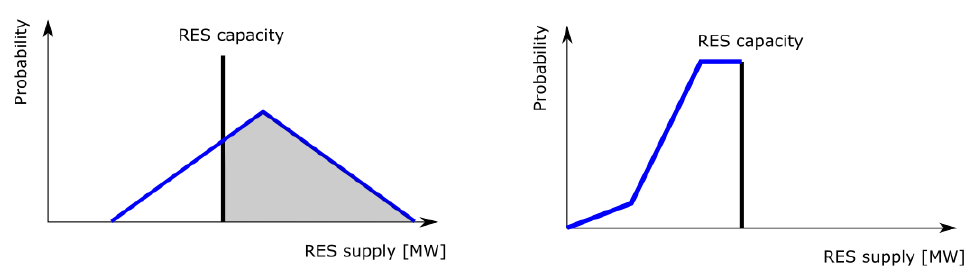
Figure 2. Left panel: Hypothetical probability distribution function of renewable supply (RES- driven imbalance plus the underlying imbalance driver) which exceeds installed RES capacity. Right panel: Probability distribution function of renewable supply which reflects on the installed capacity